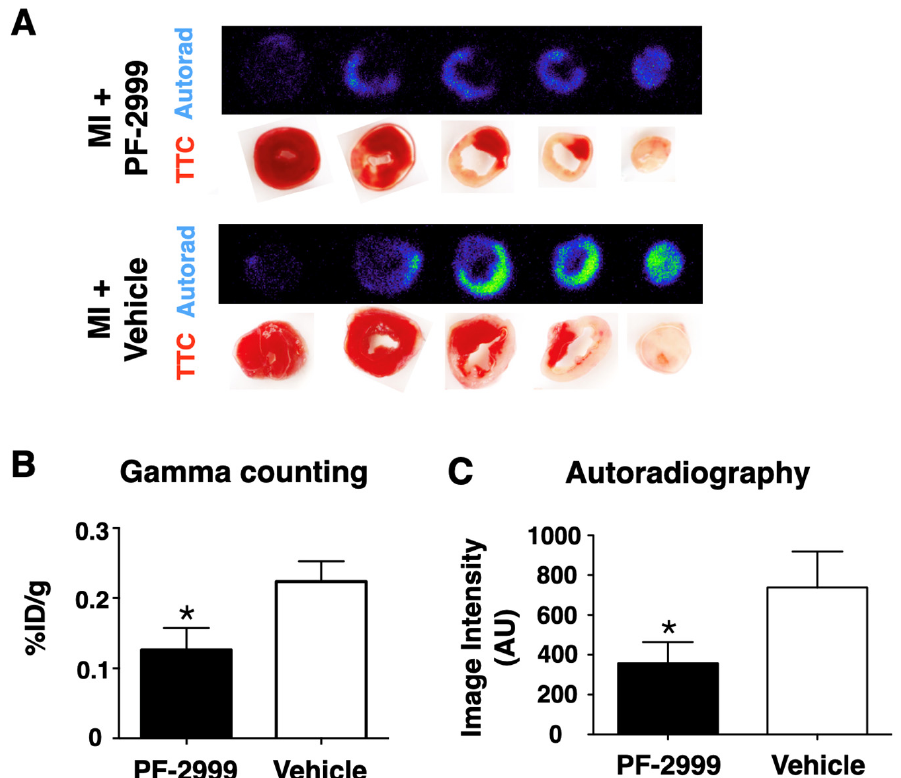
Figure 4. Ex vivo validation of 18 F-MAPP uptake in hearts. ( A ) Autoradiography of the infarcted heart slices corresponded to the tetrazolium chloride (TTC) staining for both treated (with PF-2999, 50 mg/kg, top) and vehicle (bottom) groups, demonstrating that the probe is retained in the infarcted tissue after activation by MPO. Despite a comparable extent of the infarcted tissue in both groups as visualized by TTC staining, radioactivity was significantly lower in the heart slices from PF-2999- treated animals compared to those treated with vehicle, demonstrating the ability of 18 F-MAPP to report pharmacological MPO inhibition in vivo. ( B ) Quantitative analysis by gamma counting (44% reduction with PF-2999, * p < 0.05, one-tailed t -test, n = 5 mice treated with PF-2999 and 6 with vehicle) and ( C ) quantitative analysis from autoradiography images (51% reduction with PF-2999, * p < 0.05, one-tailed t -test, n = 6 for each group). The ex vivo data from ( B , C ) corroborate the quantification of MPO activity and treatment-induced changes visualized in vivo on PET imaging in Figure